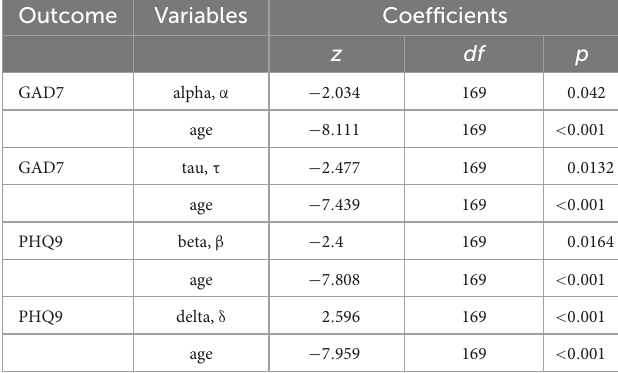
TABLE 7 Generalized linear models predict mood scores when accounting for